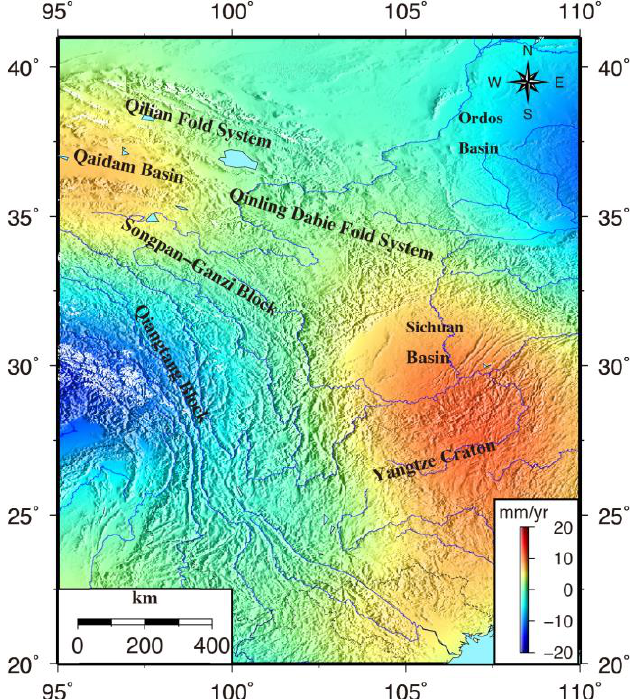
Figure 2. Surface mass changes as expressed by the equivalent water height (EWH) derived from the Gravity Recovery and Climate Experiment Release-06 (GRACE RL06) data products throughout the ETP for the period from April 2002 to August 2016.